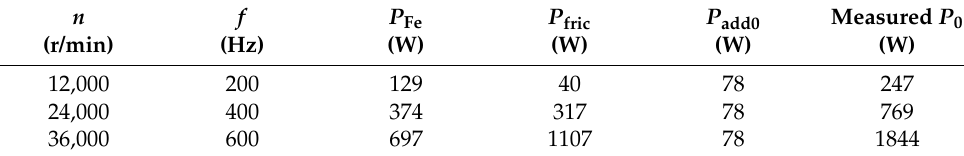
Table 6. Losses separation based on total losses of measurement at different speeds.